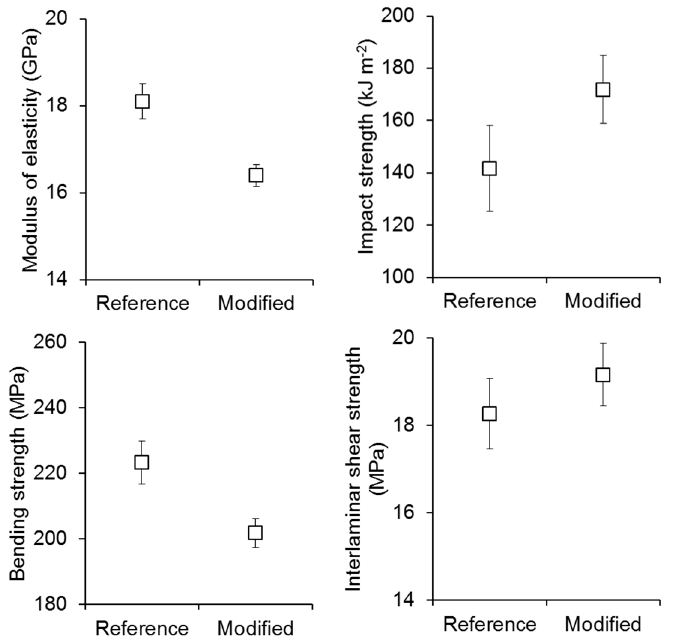
Figure 8. Results of the mechanical characterisation of glass-fibre reinforced polyester composites (unsaturated polyester resin was used as received in the reference material, the modified variant contains 1% filler consisting of polyester microspheres and MFLC fibrils).